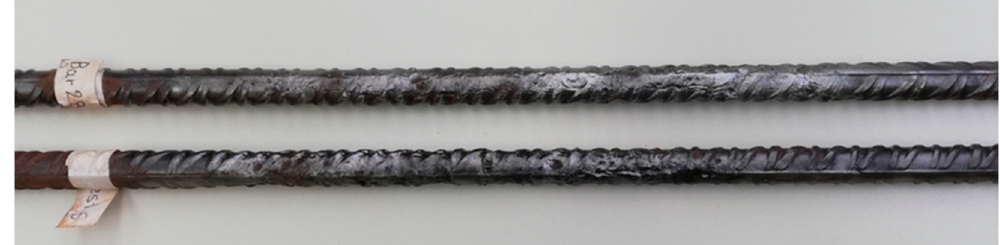
Figure 10. Pitting corrosion of embedded steel reinforcing bars and localized reduction of cross-